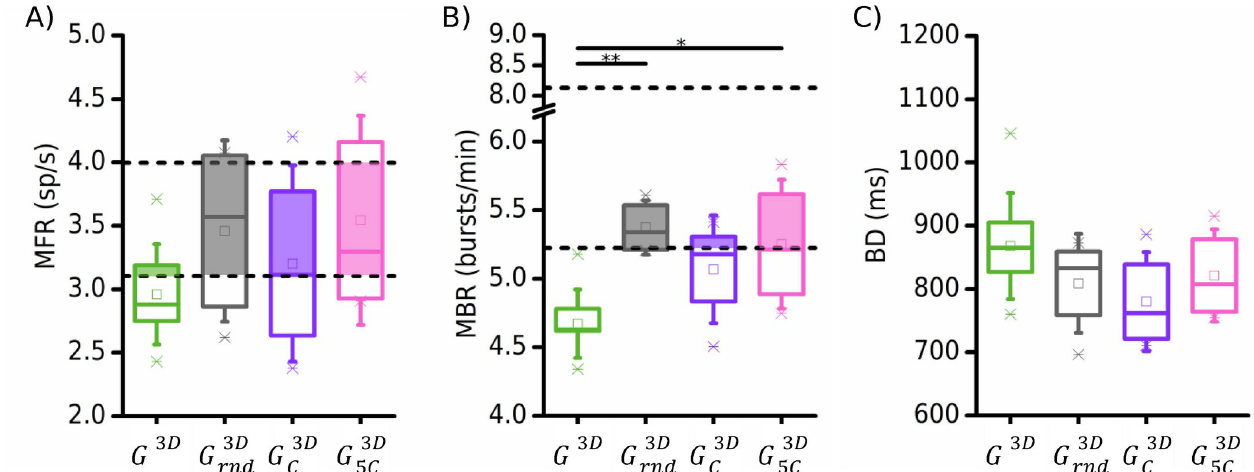
Fig 6. Effect of the inter-layer connectivity on the exhibited dynamical features of the 3D networks. Four 3D topologies have been tested, namely unrestricted ( G 3 D ), random ( G 3 D ), and organized connectivity where source neurons are located in one single central area of the network ( G 3 D rnd ). The spatial organization of these configurations is depicted in Fig 7F–7H. ( A ) Mean firing rate, ( B ) mean-bursting rate, and ( C ) burst multiple ones ( G 3 D 5 C duration of the different configurations. The box indicates the 25–75 percentile of the simulated data. The dashed black lines in the panel ( A ) and ( B ) indicate the 25–75 percentiles of the experimental data distributions. The colored shadow inside the box plots underlines the intersection between experiments and simulations. ( � refers to 0.01 < p < 0.05, �� 0.001 < p < 0.01, Kruskal-Wallis non-parametric test).